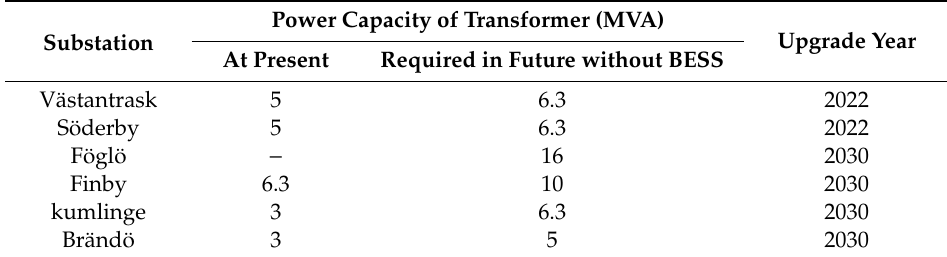
Table 2. Transformer power capacity upgrades at various locations without BESSs.